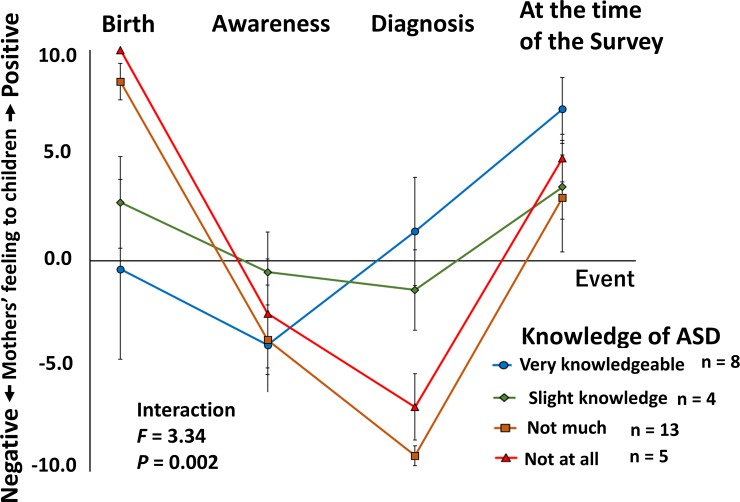
VAS scores of mothers’ feelings for their children with ASD.Group factors are the 4 levels of the mothers’ confidence in their ASD knowledge. Red triangles indicate the group in which the mothers did not know of ASD at all (n = 8). Brown squares indicate the group in which the mothers did not know much (n = 4). Green diamonds indicate the group in which the mothers have slight knowledge of ASD (n = 13). Blue circles indicate the group in which the mothers were very knowledgeable (n = 5). Two-way ANOVAs revealed significant interactions between knowledge and time (group and time points related to the diagnostic event). The values indicate the mean. Error bars represent the standard errors.